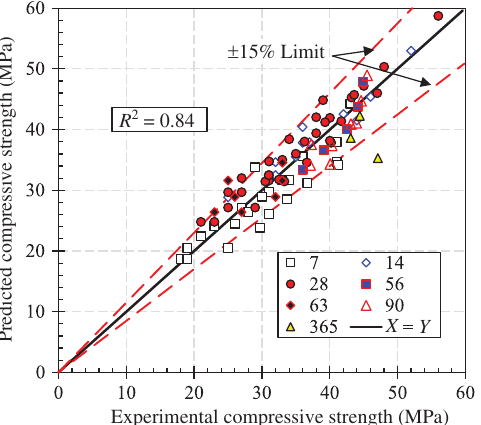
Figure 9: Comparison of experimental and predicted compressive strengths.